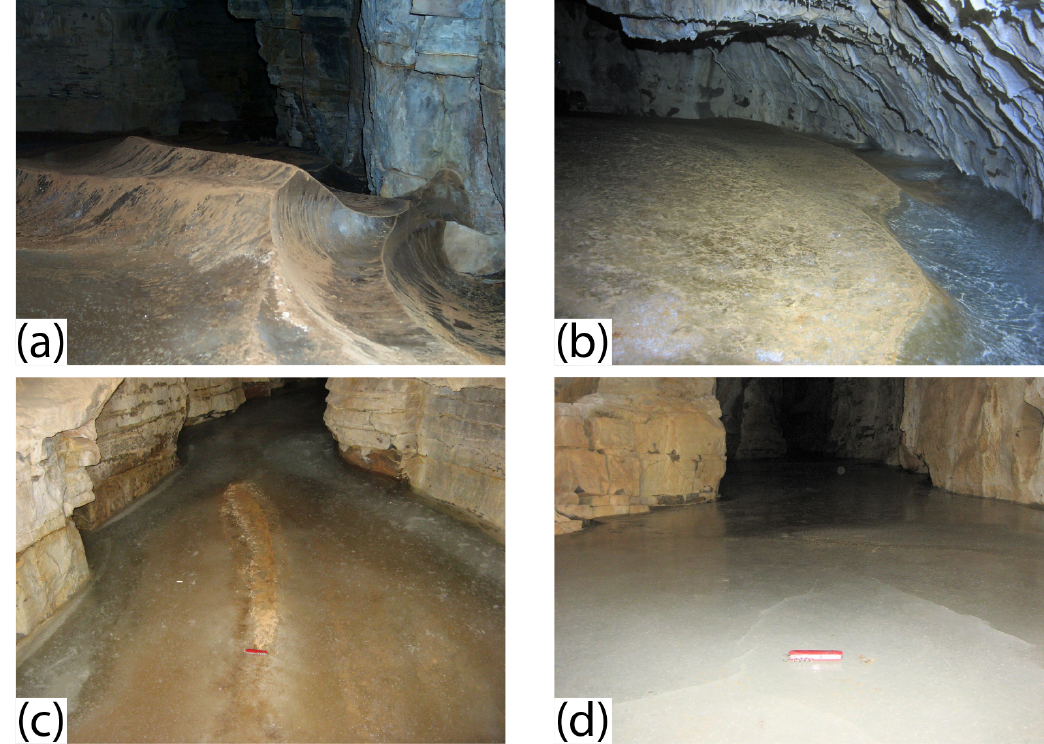
Figure 11. A selection of photographs highlighting changes observed in Winter Wonderland Cave. (a) The sculpted surface of the ice along the Frozen Freeway in 2016 illustrating numerous intersecting cuspate forms produced by sublimating air currents. The total relief is ∼ 30cm. The orange material on the ice is cryogenic-mineral precipitates. (b) A view showing the edge of the ice in the Skating Rink in 2016, where a ∼ 20cm deep moat had formed at the contact with the rock wall of the cave. (c) The surface of the Frozen Freeway in 2018 illustrating how inflowing water had submerged nearly all of the former sculpted surface under new ice. The red Swiss Army knife is located at the end of a ∼ 1m long section of the former crest in the ice that still reaches above the new ice surface. (d) Another view from a section of the Frozen Freeway in 2018, where new ice formed from inflowing water has completely inundated the former sculpted ice surface. The red pocket knife is 10cm